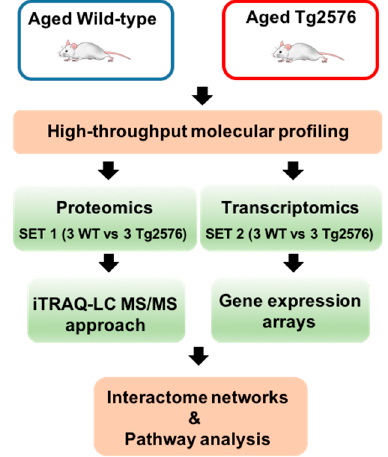
Figure 1. An overview of the workflow used for the molecular characterization of the olfactory bulbs (OBs) derived from aged Tg2576 mice.